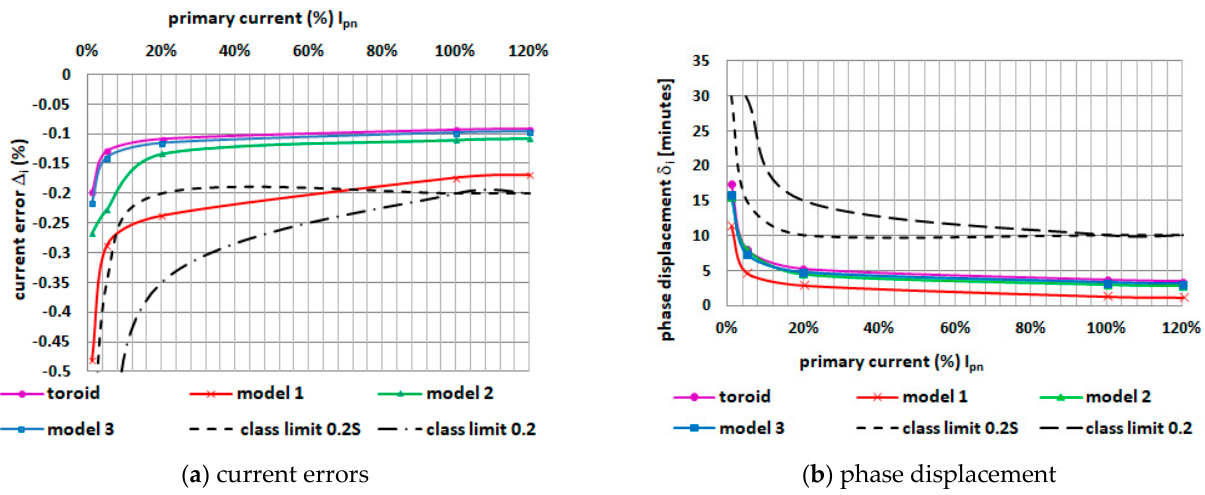
Figure 9. Comparison of the characteristics of the current error ( a ) and phase displacement ( b ) for 600 A/5 A of current transformers with different cores and secondary windings arrangements at a power load of S n = 2.5 VA. cos φ = 0.8 (I pn = 600 A).